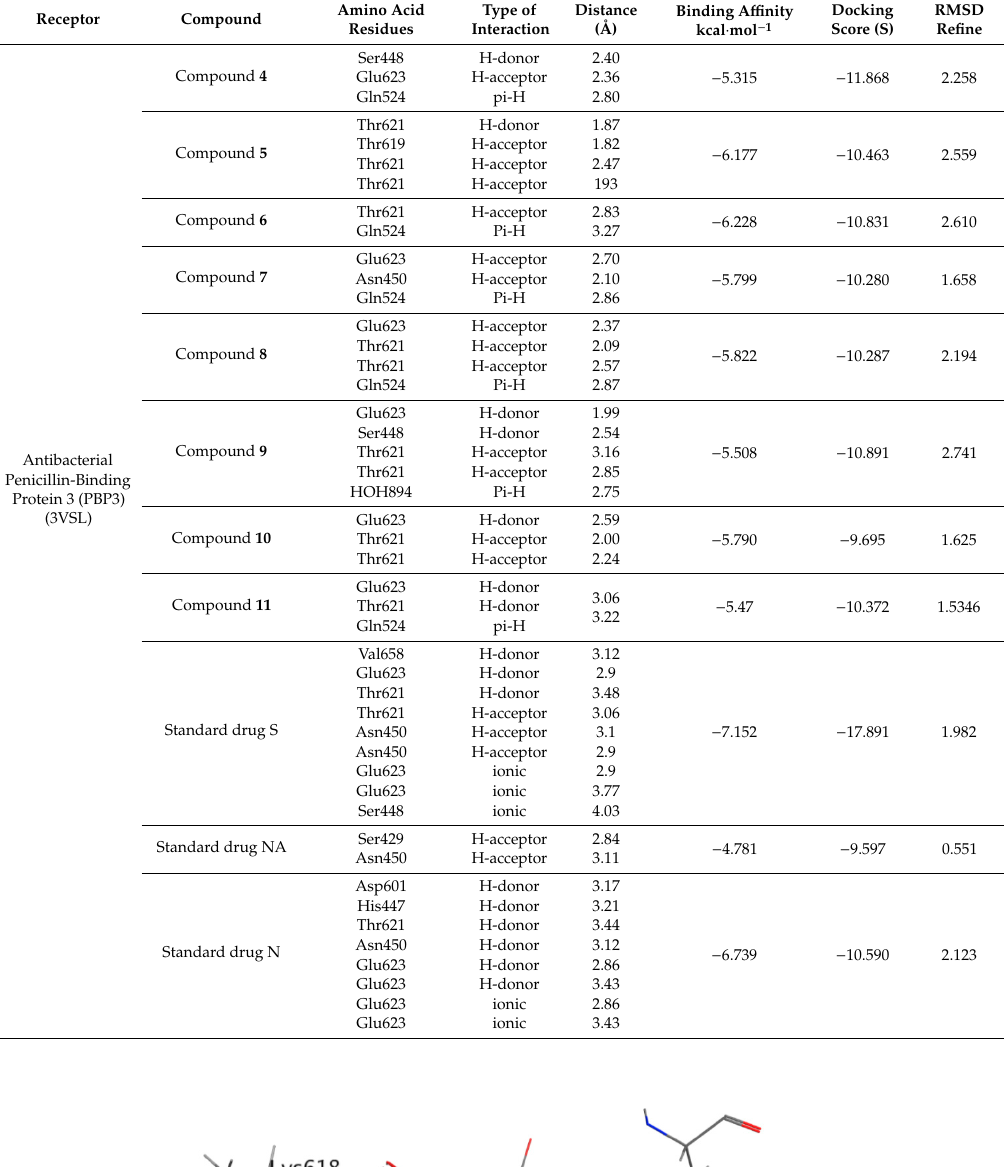
Table 2. Predicted binding-free energies ( ∆ Gbind) for ligands 4 – 11 .